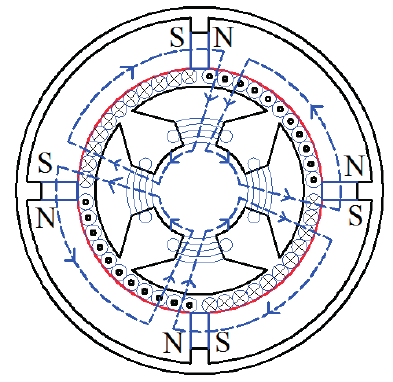
Figure 6. The magnetic circuit of Ф